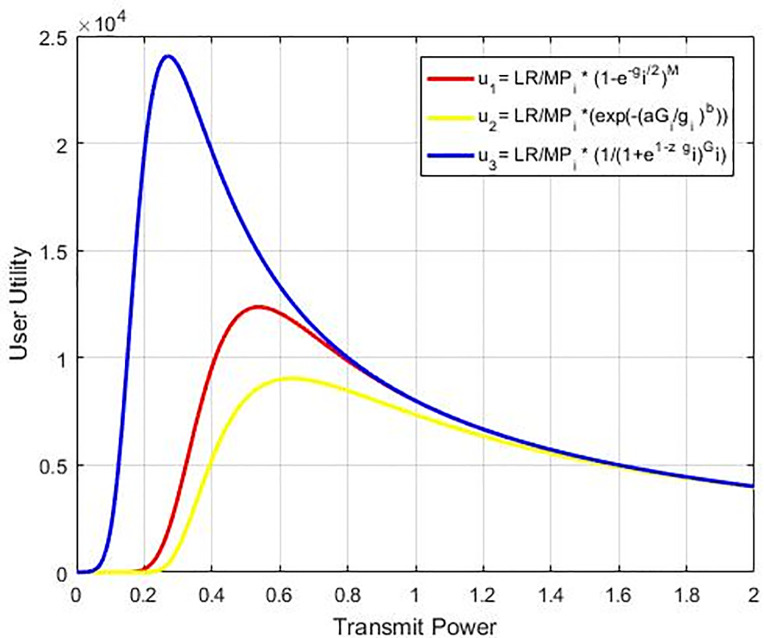
Proposed utility u3 compared to u1 [25] and u2 [15].